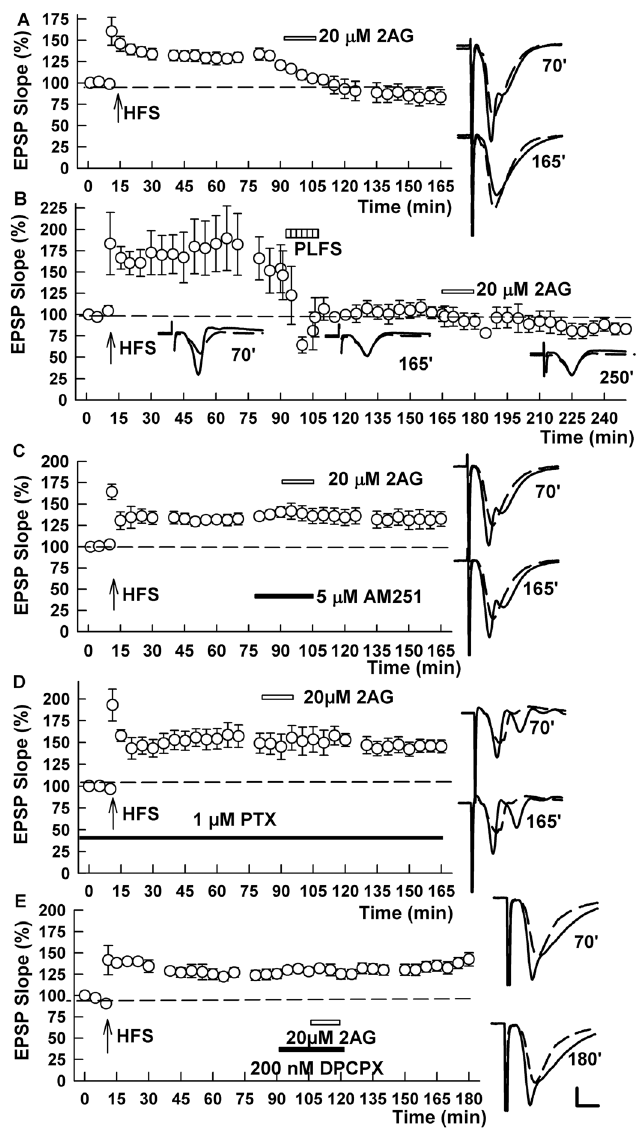
Fig 4. Exogenous administration of an endocannabinoid produces chemical depotentiation of SC LTP. (A) Perfusion of 20 μ M 2AG (white bar), an endocannabinoid agonist, reversed LTP established by SC HFS (arrow). (B) Following LTP-D induced by PLFS, 20 μ M 2AG failed to produce further suppression of SC EPSPs. (C) The effects of 2AG (white bar) on SC LTP were blocked by 5 μ M AM251 (black bar), an inhibitor of CB1 receptors. (D,E) Similarly, the effects of 2AG on SC LTP were blocked by pretreatment with 1 μ M PTX (D) and 200 nM DPCPX, an adenosine A1 receptor antagonist (E). Traces show representative EPSPs at the times indicated in the graphs. Calibration: 1 mV, 5